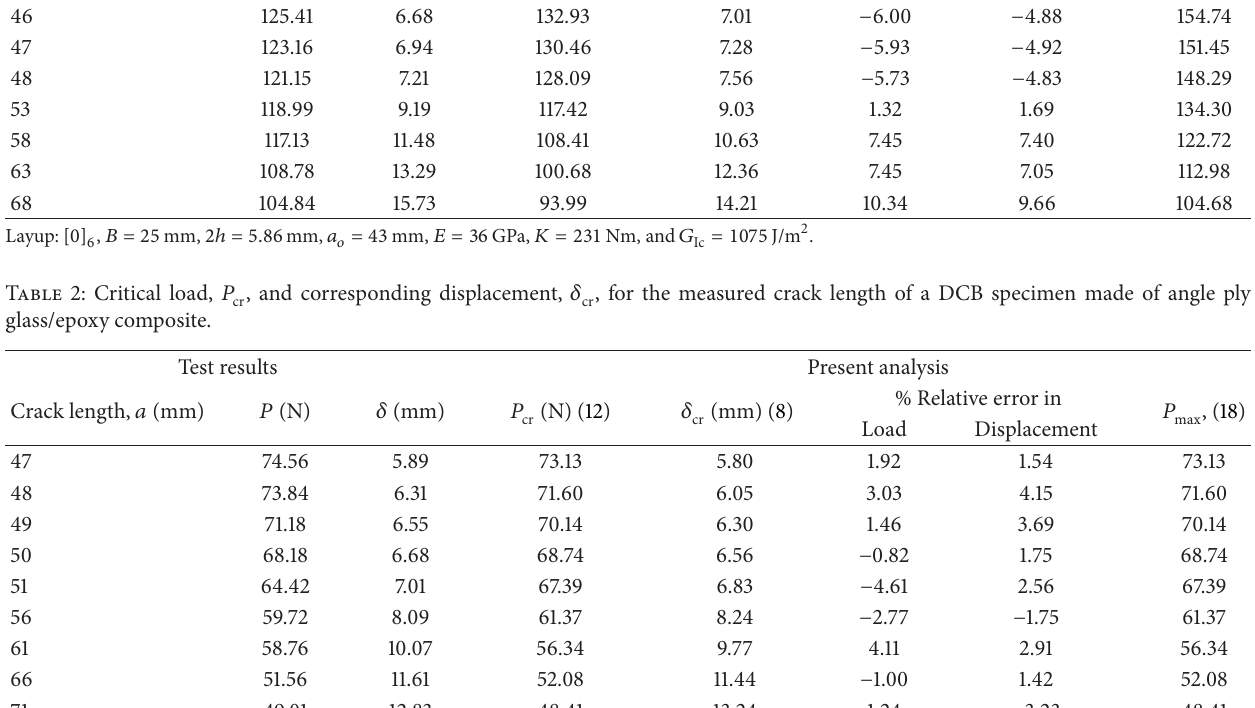
, for the measured crack length of a DCB specimen made of cross-ply cr